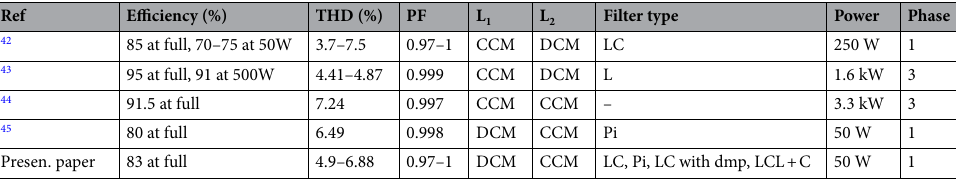
Table 3. Comparison of presented paper with the application in